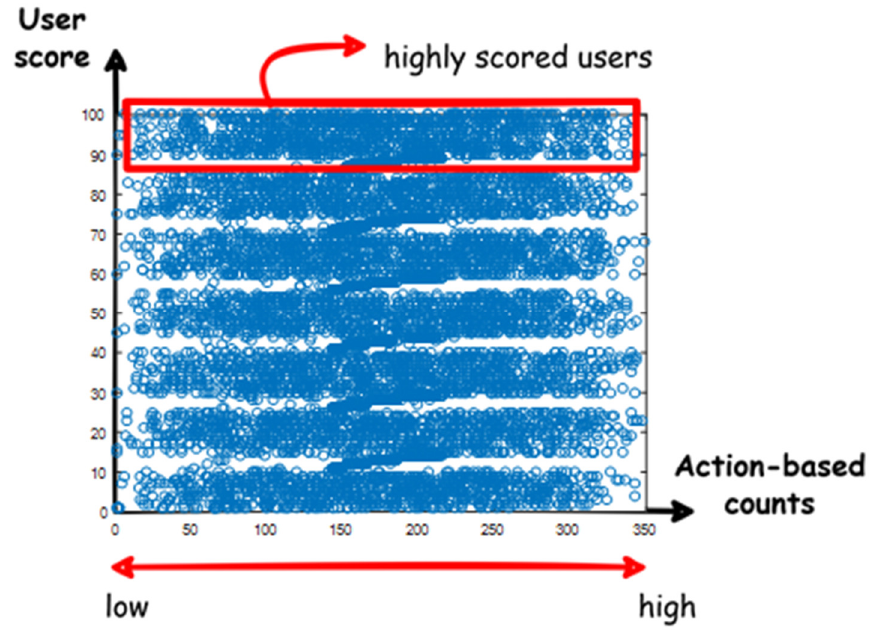
Figure 5. Correlation between users’ scores and their tweets reactions.